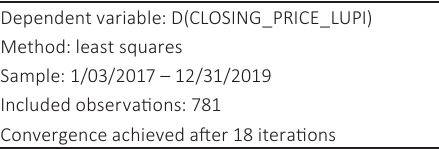
Table 6. Result of the selected model for Lupin Ltd.